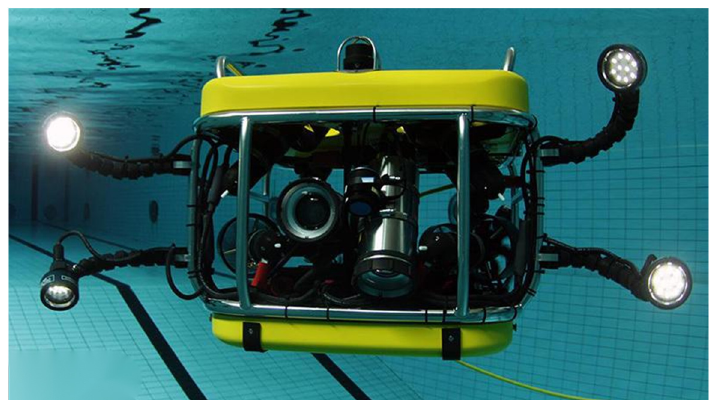
Figure 1. Current mainstream underwater robots.